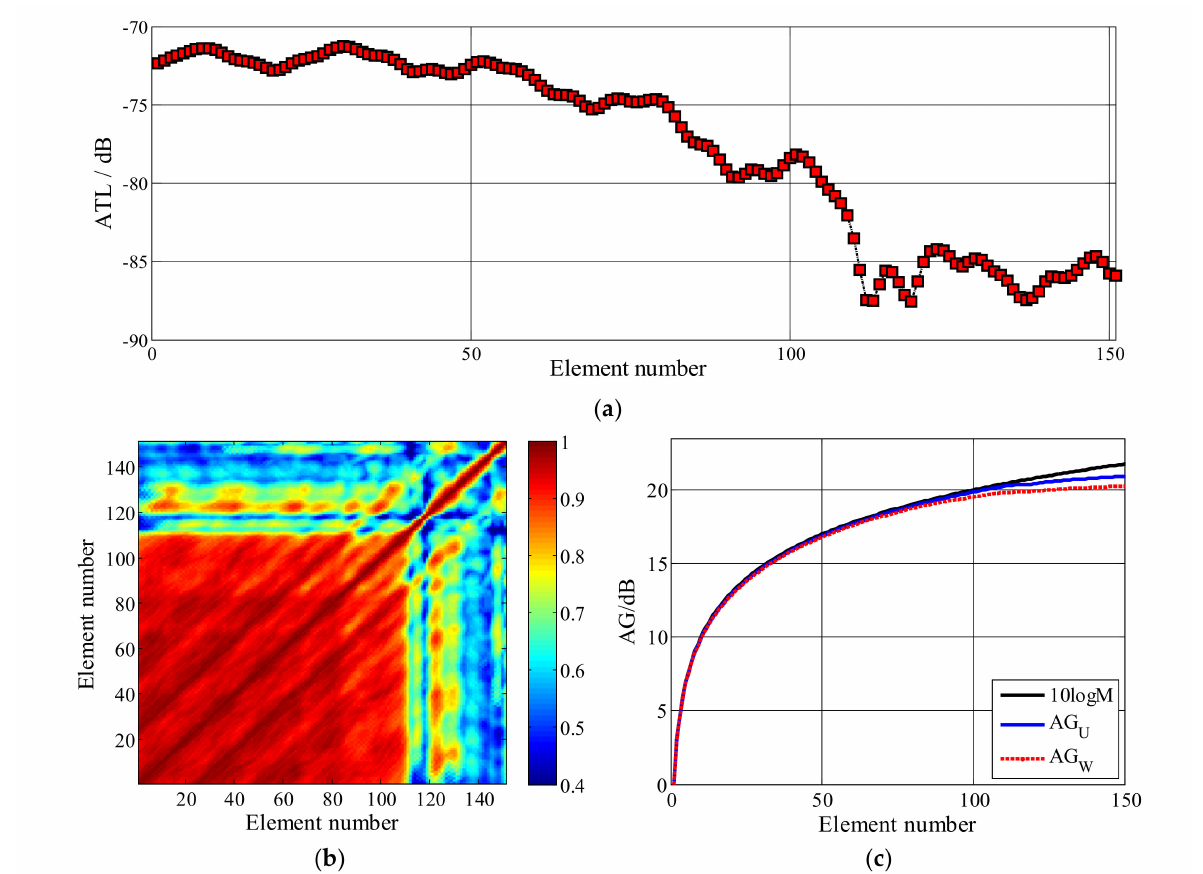
Figure 8. Fluctuant acoustic channels and AGs for the receiving depth of 120 m and distance of 48 km in the upslope waveguide: ( a ) ATL on the elements; ( b ) Correlation coefficients; ( c ) AG U (blue solid line), AG W (red dash line) and the ideal value of AG (black solid line) varying with the element